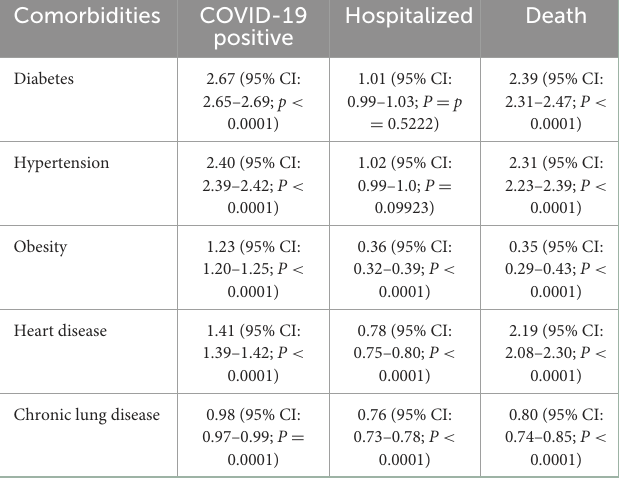
TABLE 3 Relative risks of COVID-19 positivity and its severe outcomes with individual comorbidity are presented in terms of odds ratios (ORs) with 95% confidence interval (CI 95%) and p